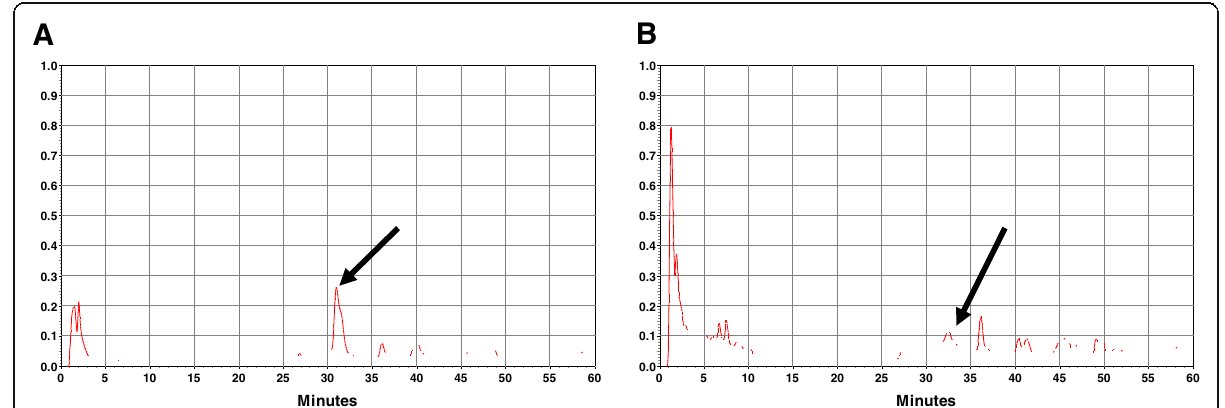
Fig. 1 a , HPLC chromtogram of α -solanine. b , HPLC chromatogram of SNME fraction. Arrow indicates the peak of α